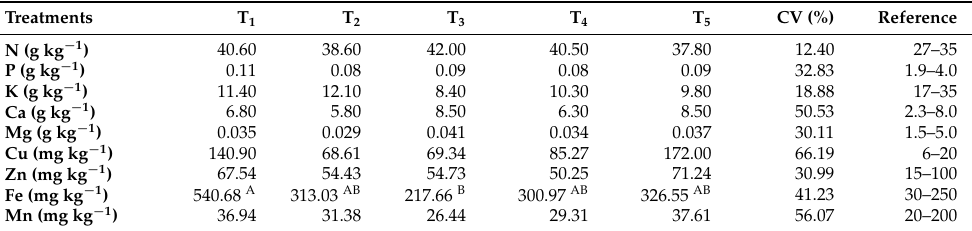
Table 6. Effect of fertilization treatments on the contents of nutrients in maize leaves at the R1 silking stage. T 1 = basal application of the digestate from swine wastewater as total substitute (100%) for synthetic N; T 2 = foliar application of the digestate as total substitute (100%) for synthetic N; T 3 = basal application of the digestate as partial substitute (50%) for synthetic N; T 4 = foliar application of the digestate as partial substitute (50%) for synthetic N; T 5 = in-row broadcast of mineral fertilizer. The treatments are fully described in Table 3.